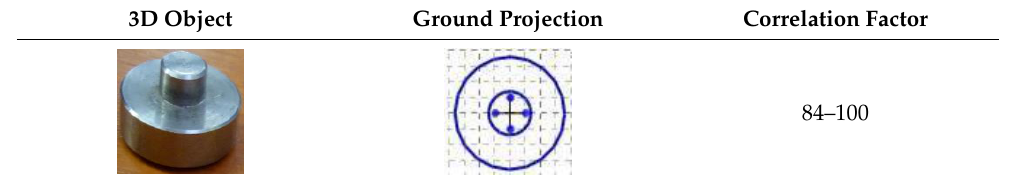
Figure 4. Realized technical solution experimental measurement stand with CCD cameras.